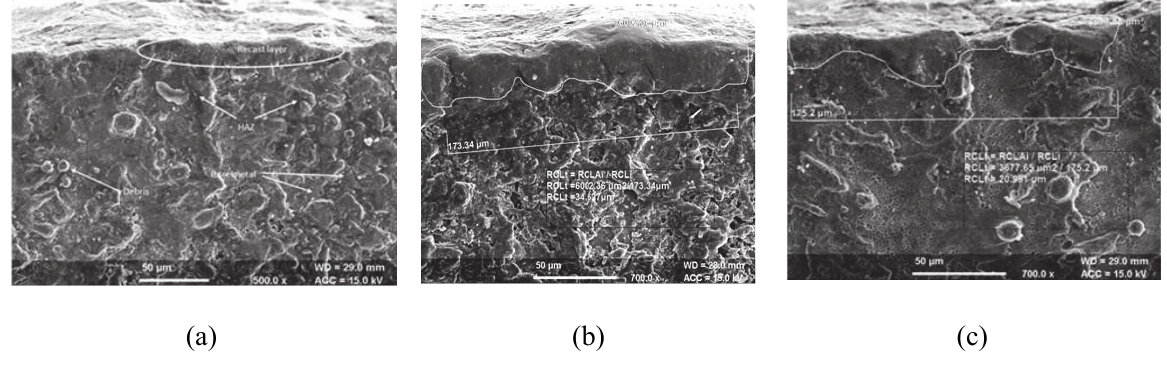
Fig. 4. Three regions developed during cutting